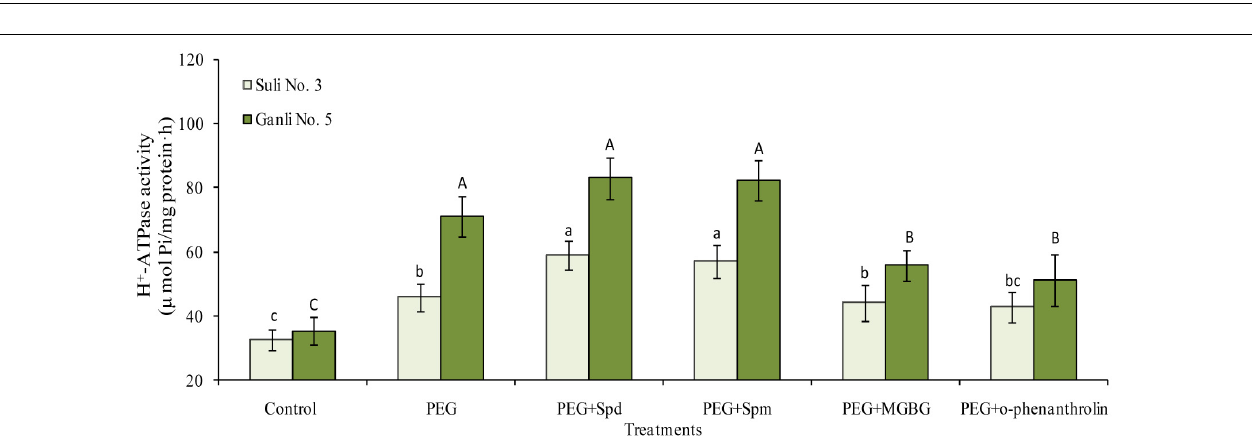
FIGURE 7 | Changes in SAMDC (A) and TGase (B) activities. Control: treatment without PEG or the other reagents (–0.15 MPa); PEG: treatment with PEG (–0.85 MPa); PEG + Spd: treatment with PEG and Spd (1 mM); PEG + Spm: treatment with PEG and Spm (1 mM); PEG + MGBG: treatment with PEG and MGBG (0.5 mM); PEG + o-phenanthroline: treatment with PEG and o-phenanthroline (0.2 mM). The data here were means ( n = 9) ± standard error of 3 independent experiments. Significant differences between treatments are indicated with letters, with upper and lower letters for each cultivar ( P < 0.05).